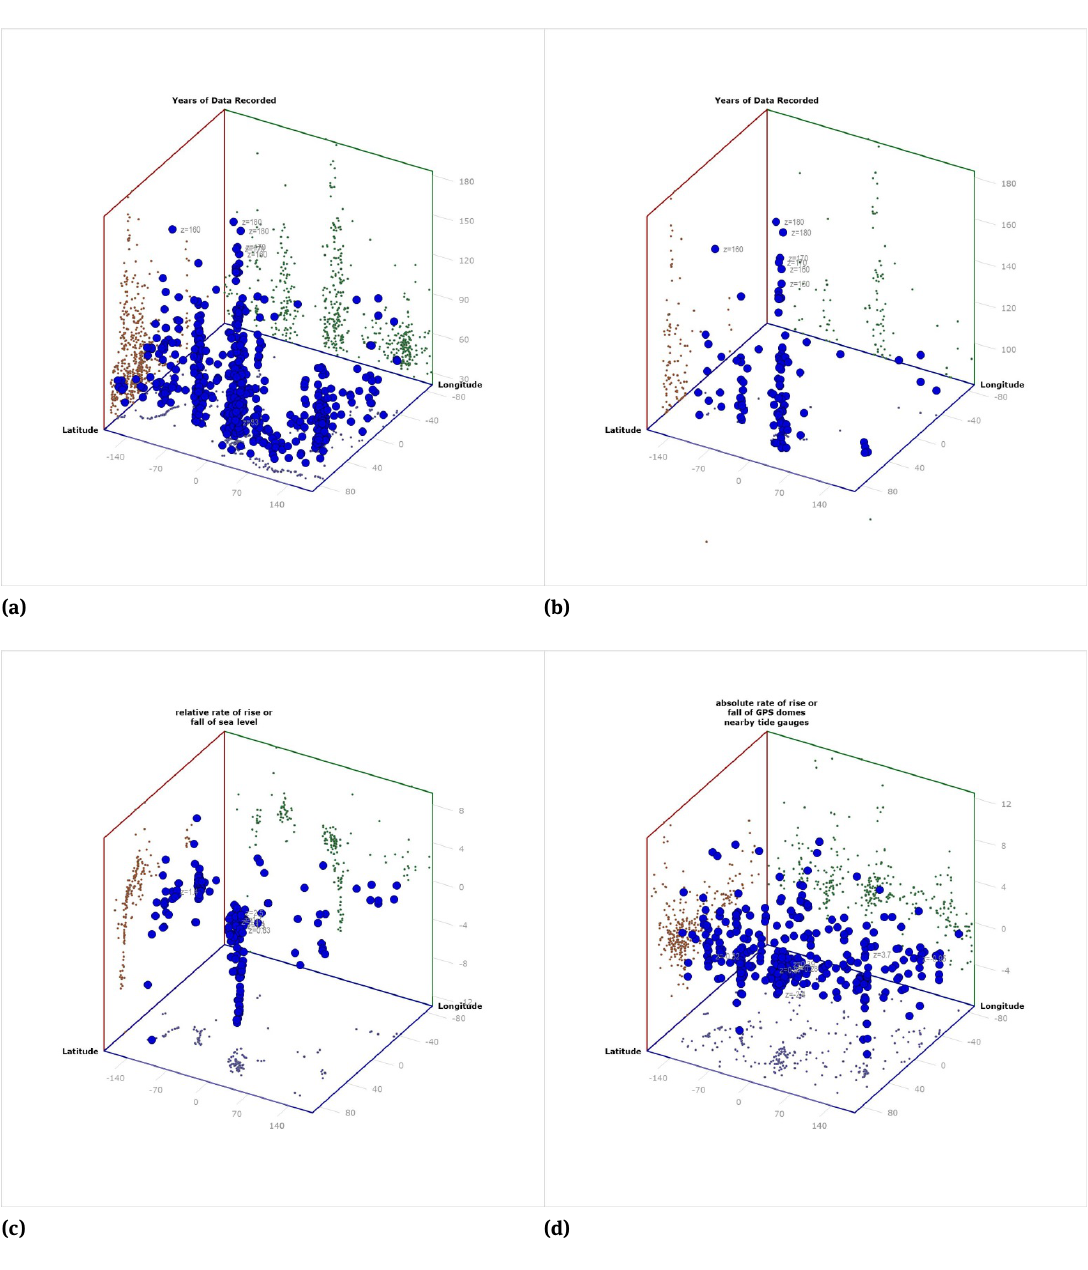
Fig. 2. Geographical distribution of recorded years for the tide gauges of the world of the latest PSMSL survey, all the tide gauges and 80 + years tide gauges, the relative rate of rise of these latter tide gauges, and the geographical distribution of the land motion of GPS domes nearby the tide gauges from the latest SONEL survey. Clearly, to talk about a global mean sea level rate of rise is pure non-sense as the scattered information does not permit. From what is actually available measured at the tide gauges, the only possible claim is that the few tide gauges of enough quality and length displaced along the coastline are acceleration free over the last 20 years of the satellite madness and rising of average of only 0.24 mm/year without any detectable acceleration component.